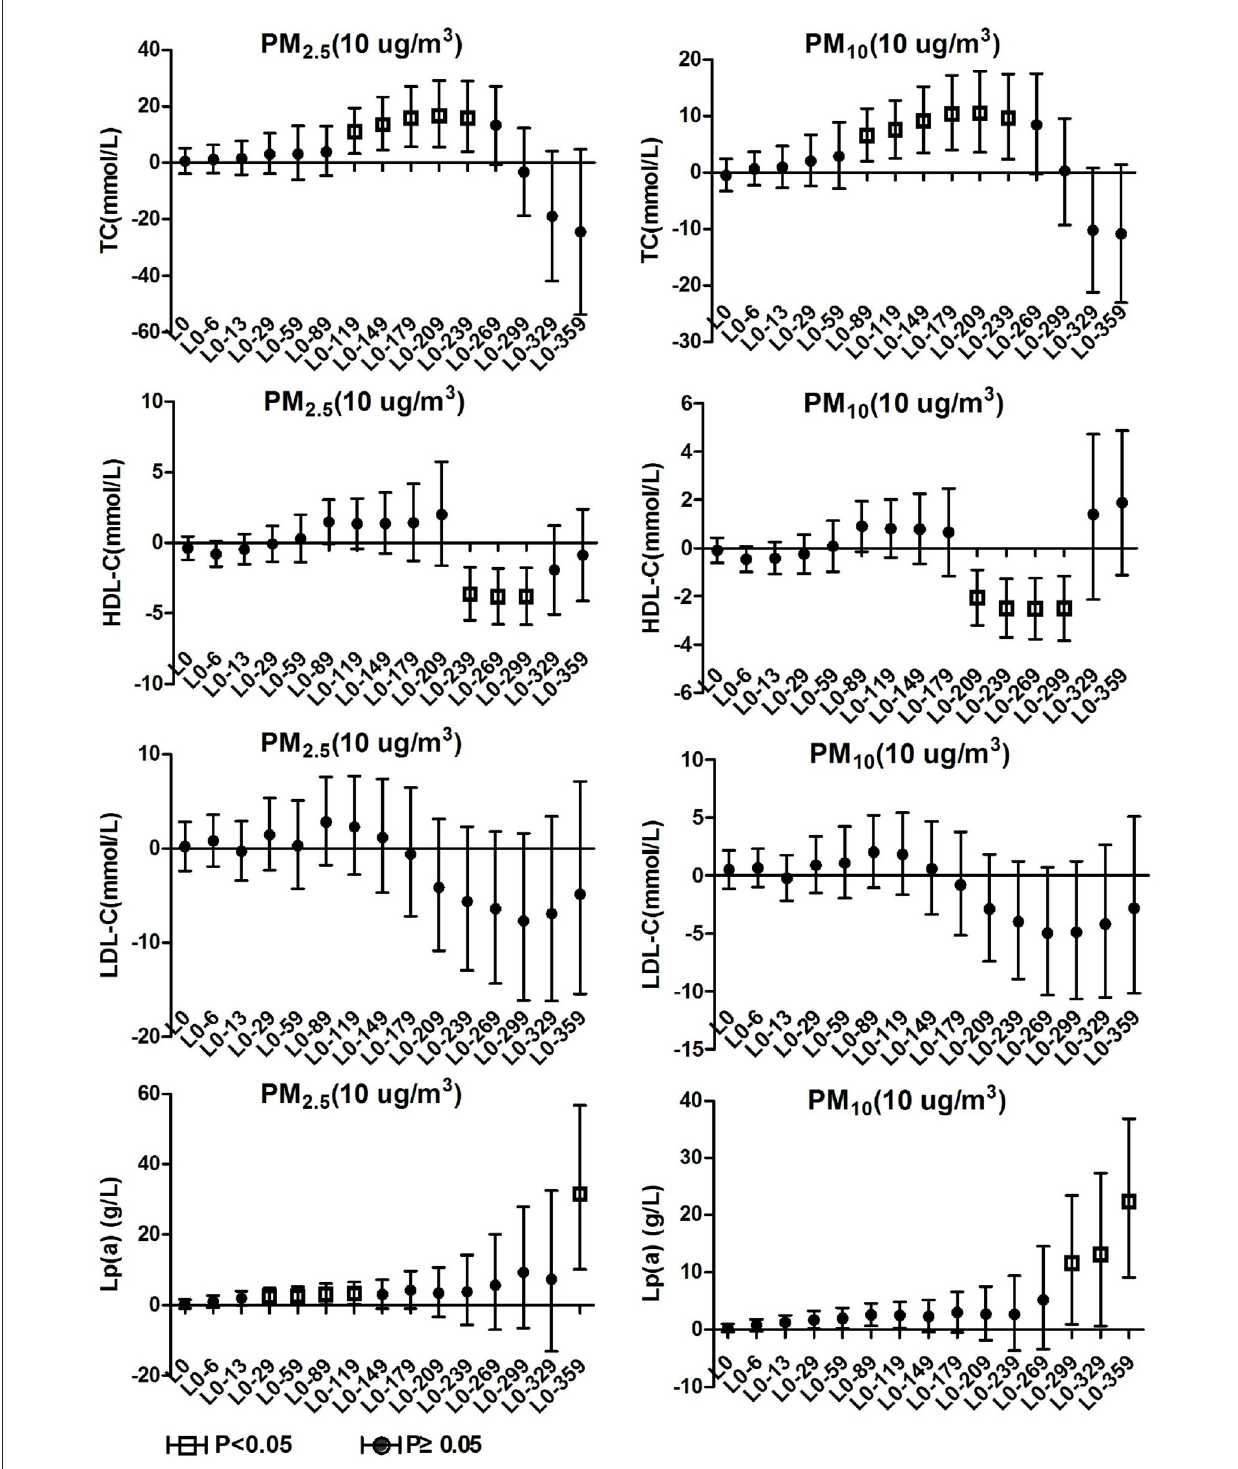
FIGURE5 Effect of PM 2.5 and PM 10 on blood lipid in total hypertensive inpatients.